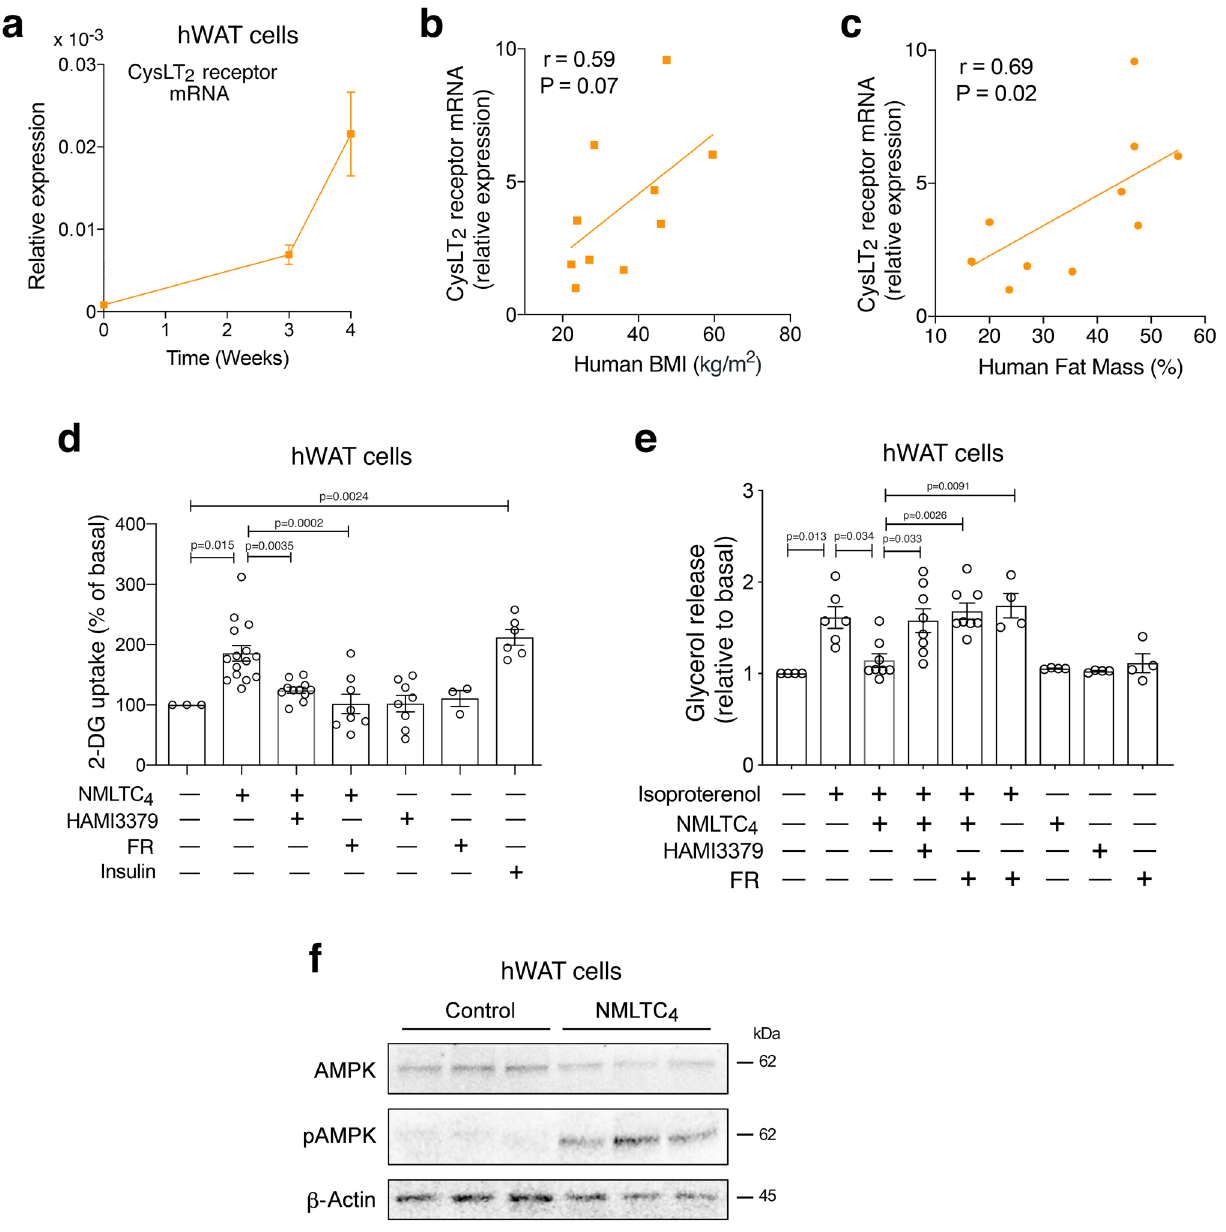
Fig. 7 Agonist stimulation of the CysLT 2 receptor promotes glucose uptake and inhibits lipolysis in human white adipocytes. a Changes in mRNA levels of the CysLT 2 receptor during the differentiation of human white adipocytes (hWAT cells). b Correlation between human body mass index (BMI) and CysLT 2 receptor mRNA expression levels in human subcutaneous fat ( n = 10; samples were from 10 different individuals). c Correlation between human fat mass (% of body weight) and CysLT 2 receptor mRNA expression levels in human subcutaneous fat ( n = 10; samples were from 10 different individuals). d Stimulation of 2-deoxy-D-glucose (2-DG) uptake by differentiated hWAT cells by NMLTC 4 , a selective CysLT 2 receptor agonist (1 μ M). HAMI3379, a selective CysLT 2 receptor antagonist (1 μ M) and FR900359 (FR; G q/11 inhibitor; 1 μ M) blocked this response. For control purposes, cells were also treated with insulin (10 nM). e Stimulation of glycerol release from differentiated hWAT cells by isoproterenol (100 nM). This effect was completely blocked by NMLTC 4 (1 μ M). The anti-lipolytic effect of NMLTC 4 was absent in the presence of HAMI3379 (1 μ M) or FR (1 μ M). Glucose uptake and glycerol release data were normalized relative to values obtained in the absence of any drugs. f Western blotting studies with differentiated hWAT cells. Treatment with NMLTC 4 (1 μ M) for 60 min promotes the phosphorylation of AMPK ( α -subunit). This experiment was independently repeated twice with similar results. The correlation analysis shown in ( b , c ) was conducted by Spearman ’ s test (two-tailed, no adjustment for multiple comparisons). The data shown in ( a , d , e ) are means ± s.e.m. obtained in at least three independent experiments. In ( d , e ), data were expressed relative to basal levels measured in the absence of any drugs (one-way ANOVA followed by Bonferroni ’ s post-hoc test). Source data are provided as a Source data fi le.